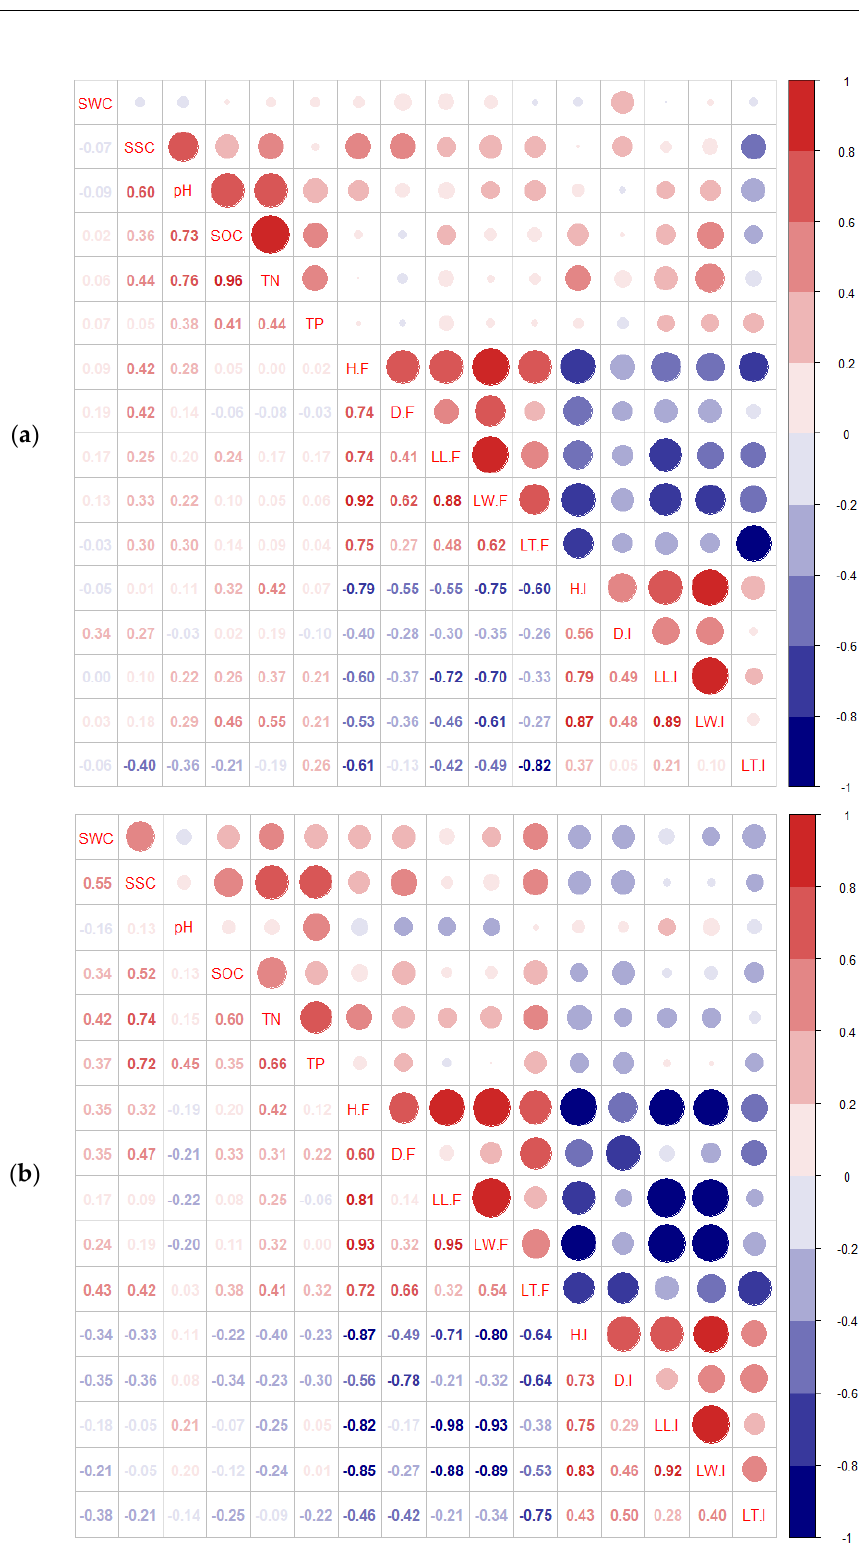
Figure 4. Correlation between interspecific and intraspecific variation and soil factors under different water gradients. ( a ) High moisture gradient; ( b ) low moisture gradient. SWC—soil water content, SSC—soil salt content, pH—pH value, SOC—soil organic carbon, TN—total nitrogen, TP—total phosphorus, H—plant height, D—diameter at breast height/base diameter, LL—leaf length, LW—leaf width, LT—leaf thickness. F denotes interspecific variation, and I denotes intraspecific variation.